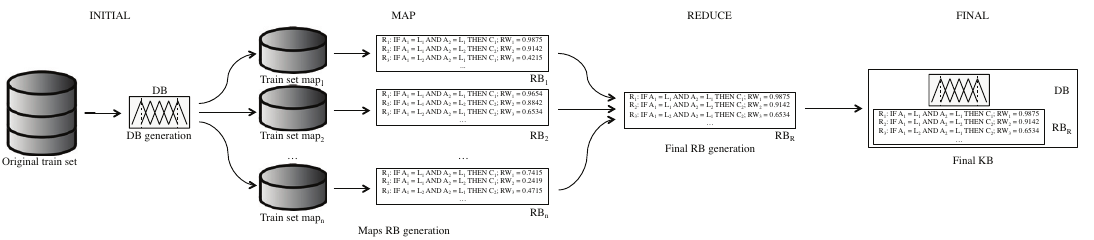
Figure 2: A flowchart of how the building of the KB is organized in Chi-FRBCS-BigData